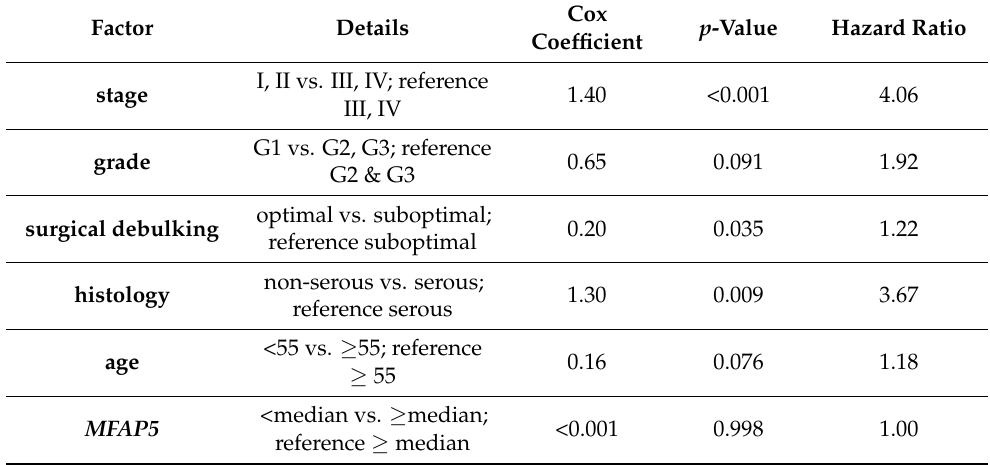
Multivariate analysis—OS (We calculated HR from the exponentiated coefficients (exp(Cox coefficient) = hazard ratio), based on data from CSIOVDB).